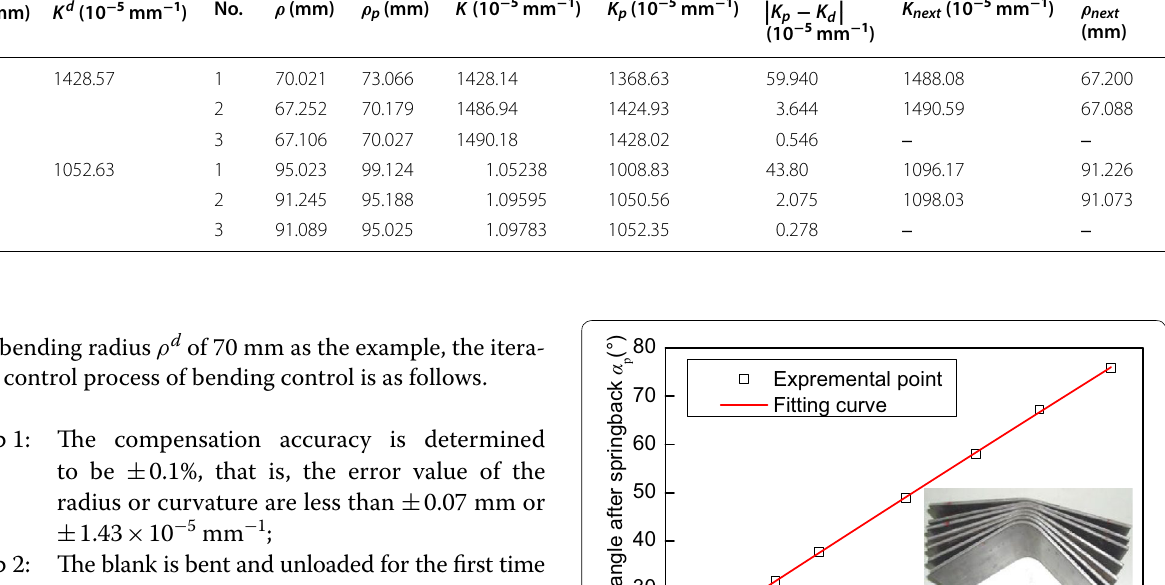
Table 2 The iterative compensation process of curvature in V‑free bending ρ d (mm) K d (10 − 5 mm − 1 )